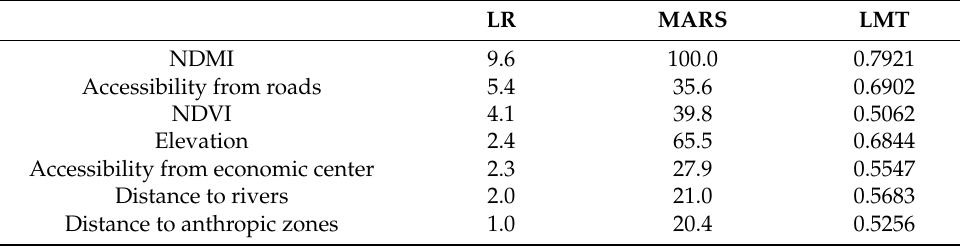
Table 2. Variable importance of the forest fire occurrence independent variables using the varImp function from Caret package. In the three algorithms analyzed, the most important variable turned out to be the NDMI index; while the variable with the least impact for the models based on LR and MARS was Distance to anthropic zones, for the LMT algorithm the variable with least importance was the NDVI index.